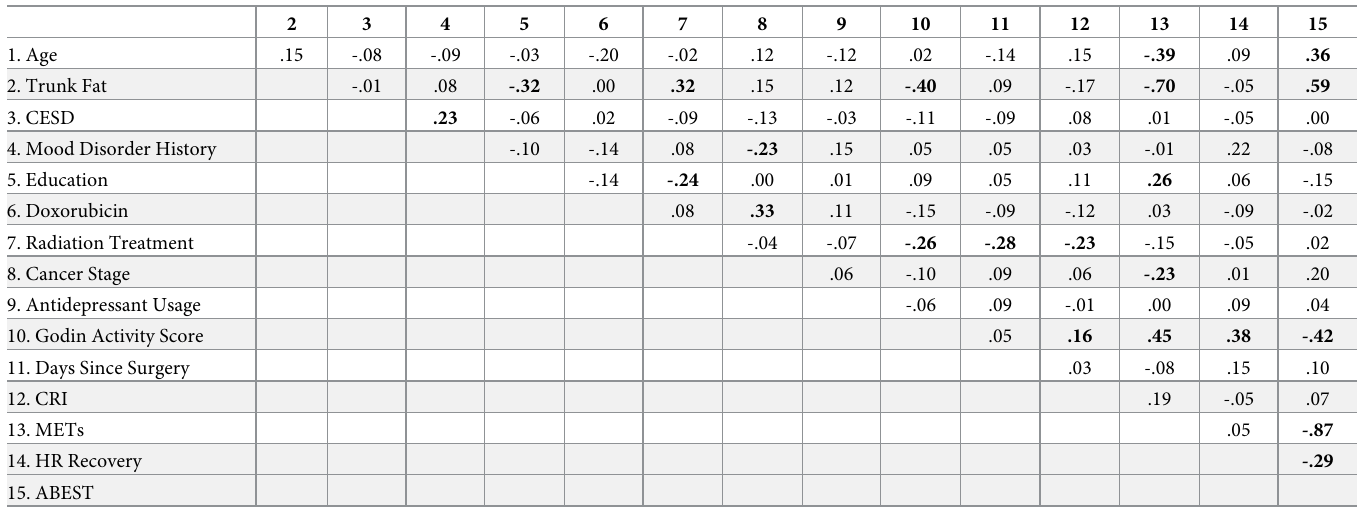
Table 2. Zero-order Pearson correlations among variables of interest at Visit 1.